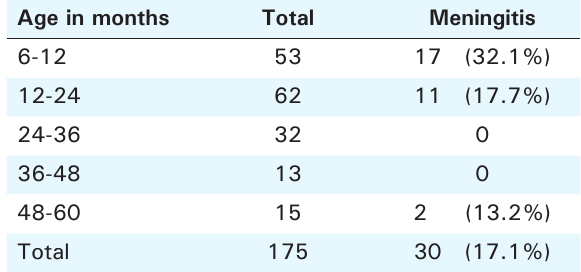
Table 1. Distribution of meningitis in different age groups